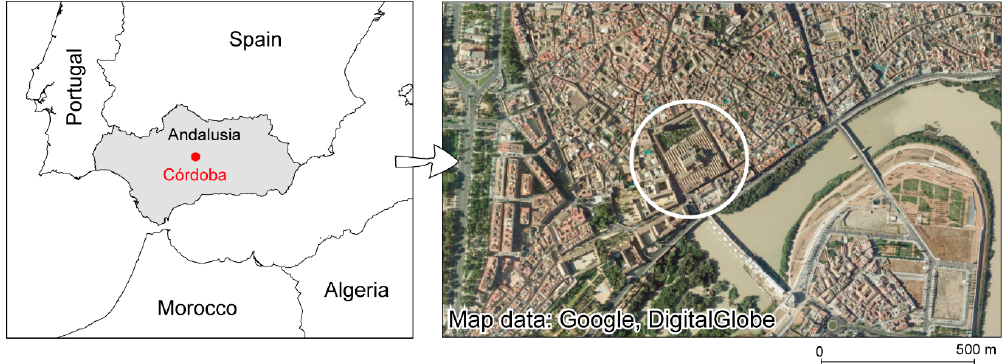
Figure 1. Location of the Mosque-Cathedral of Córdoba.